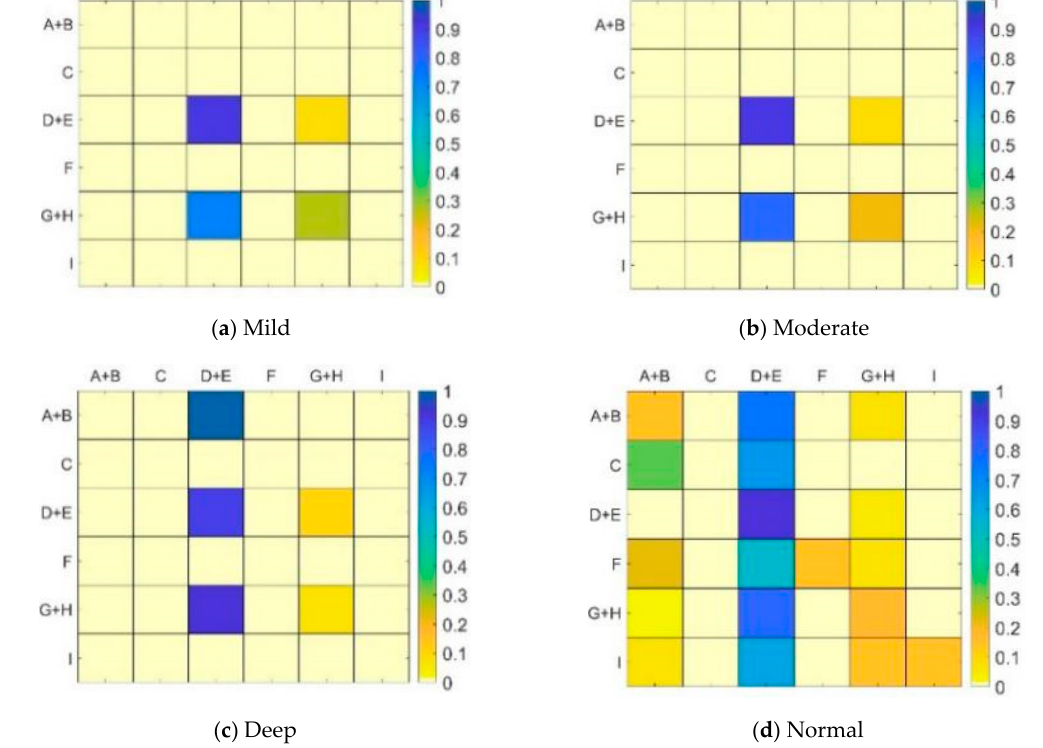
Figure 11. Two-step transition probability matrix under different states. ( a ) Mild ( b ) Moderate( c ) Deep ( d ) Normal.